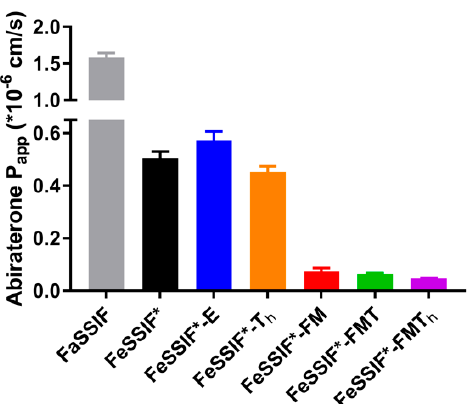
Figure 1. Apparent permeability coefficients ( P app ) of the AMI ‐ system for abiraterone (solution) in FaSSIF and different simulated media reflecting the fed state (F = fatty acids, M = monoglycerides, T = triglycerides, T h = high triglycerides, E = Ensure Plus). Data are shown as mean ± SD (n = 3).